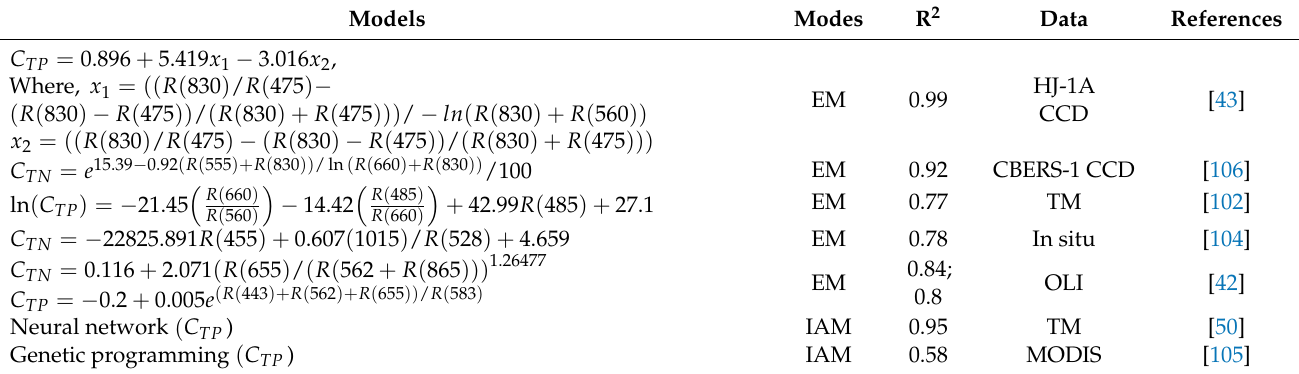
Table 6. Inversion models of TP and